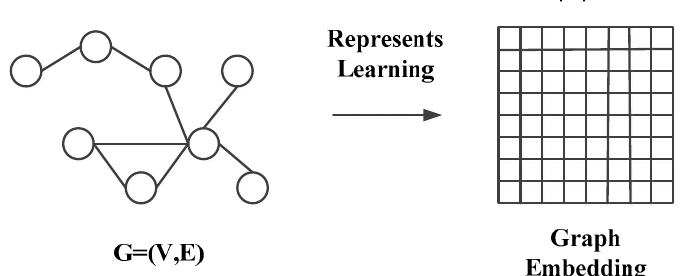
Figure 1. Graph embedding process.